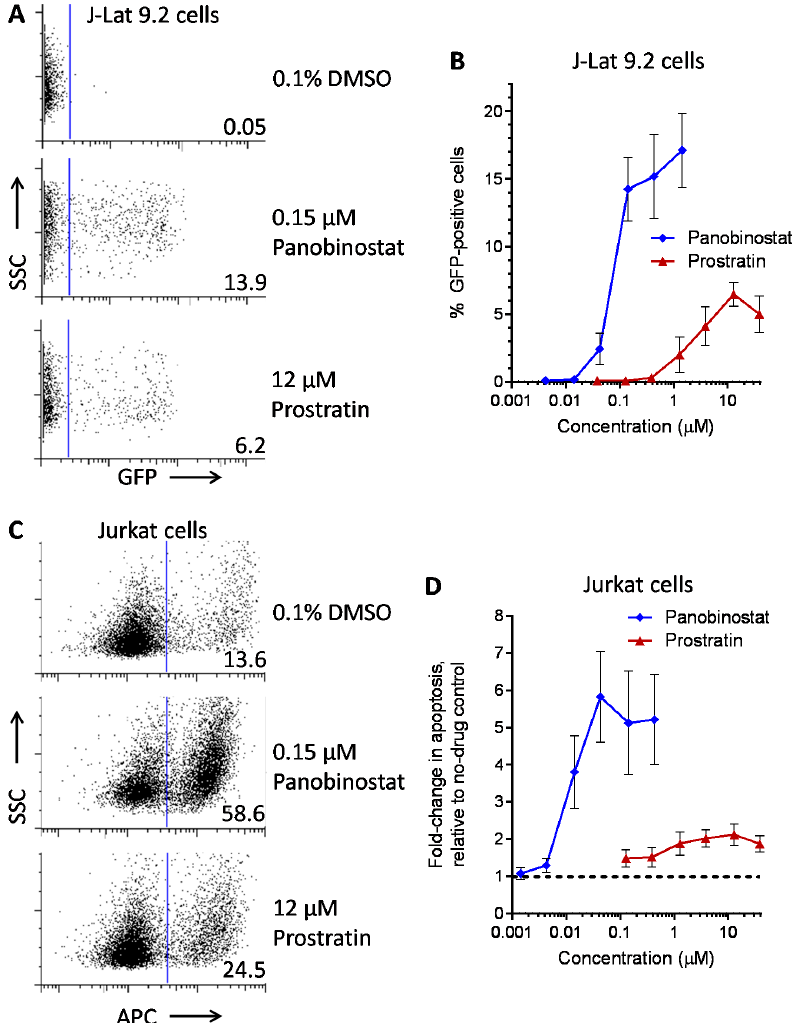
Figure 1. HIV-1 latency reversal and cellular toxicity assessments of control LRAs. ( A ) Representative GFP expression in J-Lat cells treated with 0.1% DMSO (top), 0.15 µM panobinostat (center), or 12 µM prostratin (bottom). Numbers to the right of the blue bar indicate percent GFP-positive (i.e., HIV-expressing) cells. ( B ) Effects of control LRAs on HIV-1 provirus expression in J-Lat cells. ( C ) Representative effects of compounds on apoptosis in Jurkat cells, as measured by annexin V staining. Numbers to the right of the blue bar indicate percent APC-positive (i.e., apoptotic) cells. ( D ) Effects of control LRAs on apoptosis in Jurkat cells, expressed as fold-increase in apoptosis relative to control cultures treated with 0.1% DMSO (dotted line).